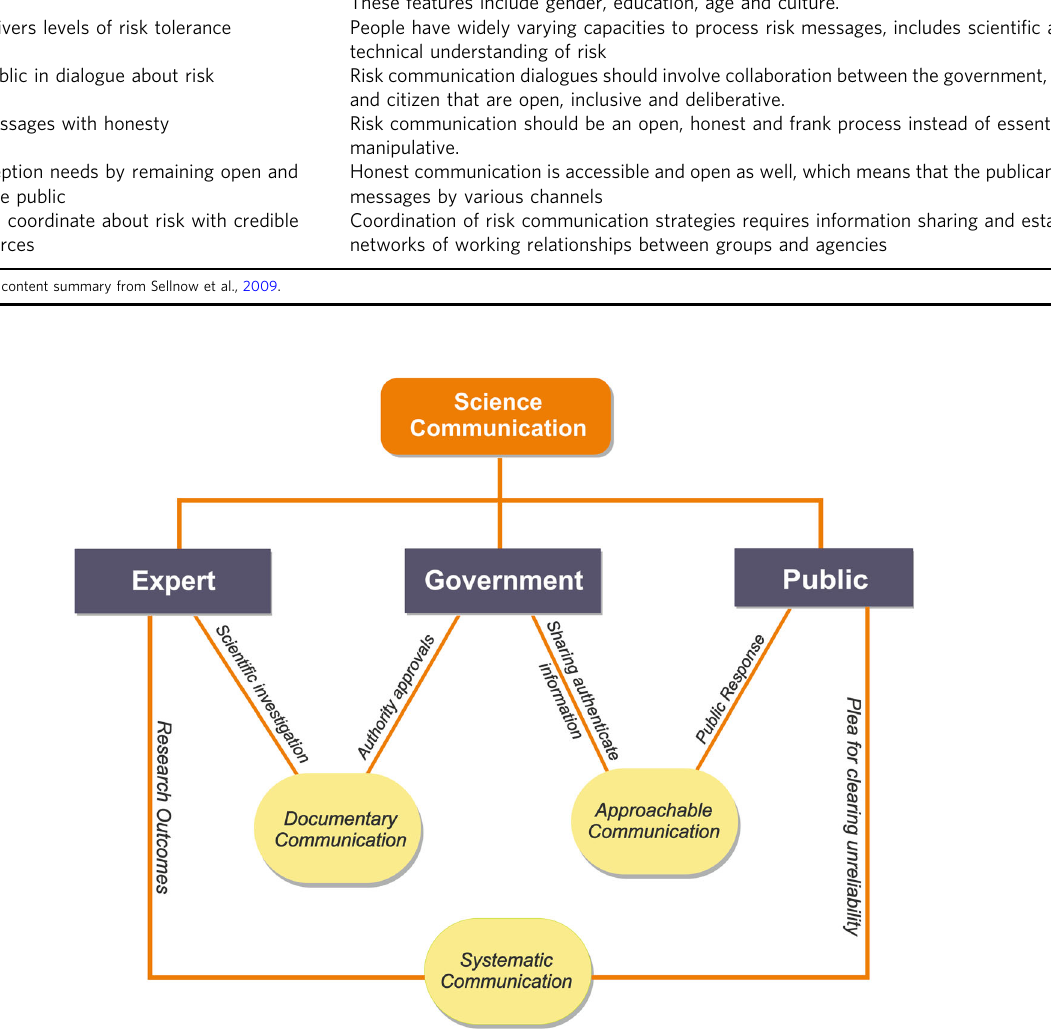
Fig. 6 A model de fi ning science communication between Government, Expert and Public t (Zhang et al.,